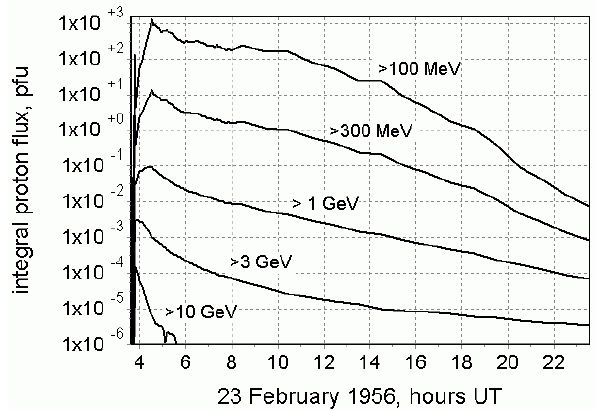
Fig. 11. Integral flux of protons with energies > 100MeV, > 300MeV, > 1, > 3 and > 10GeV.